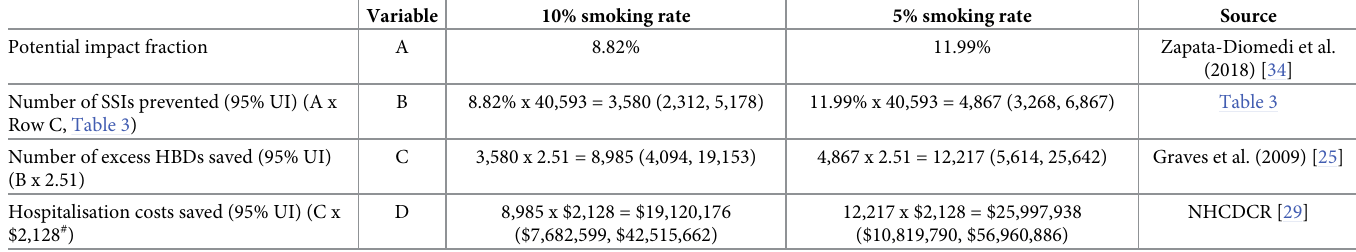
Table 4. Estimated annual expected number of surgical site infections prevented and associated hospital bed-days and costs saved in Australian public hospitals resulting from reducing the surgical patient smoking rate from 23.9% to 10% or 5%.